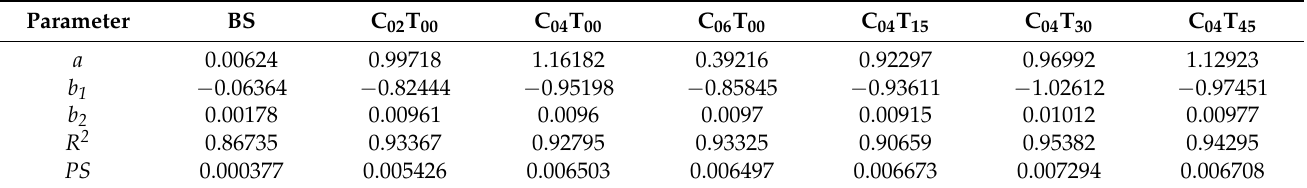
Table 7. Fitting curve parameters of cement-based composites under 150 freeze-thaw